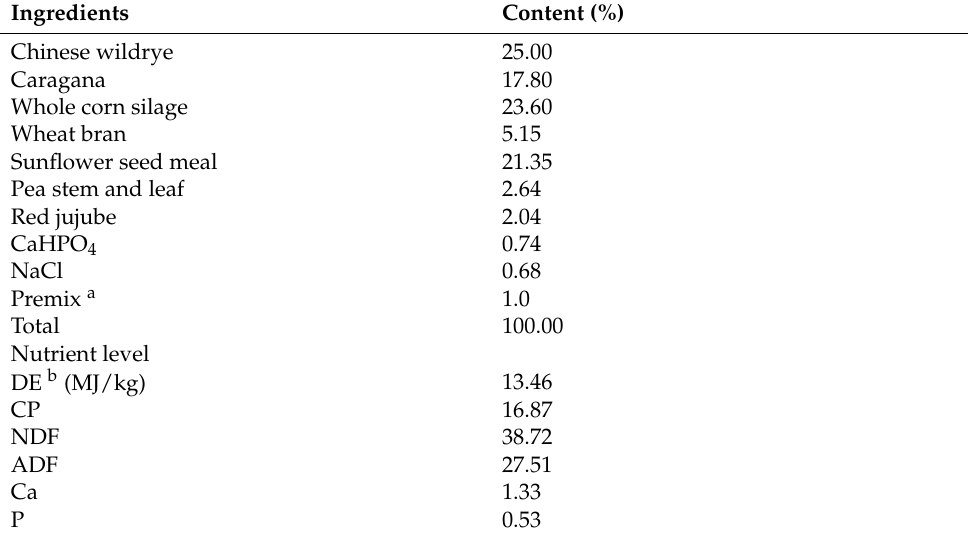
Table 1. Composition and nutrient levels of the basal diet (dry matter basis